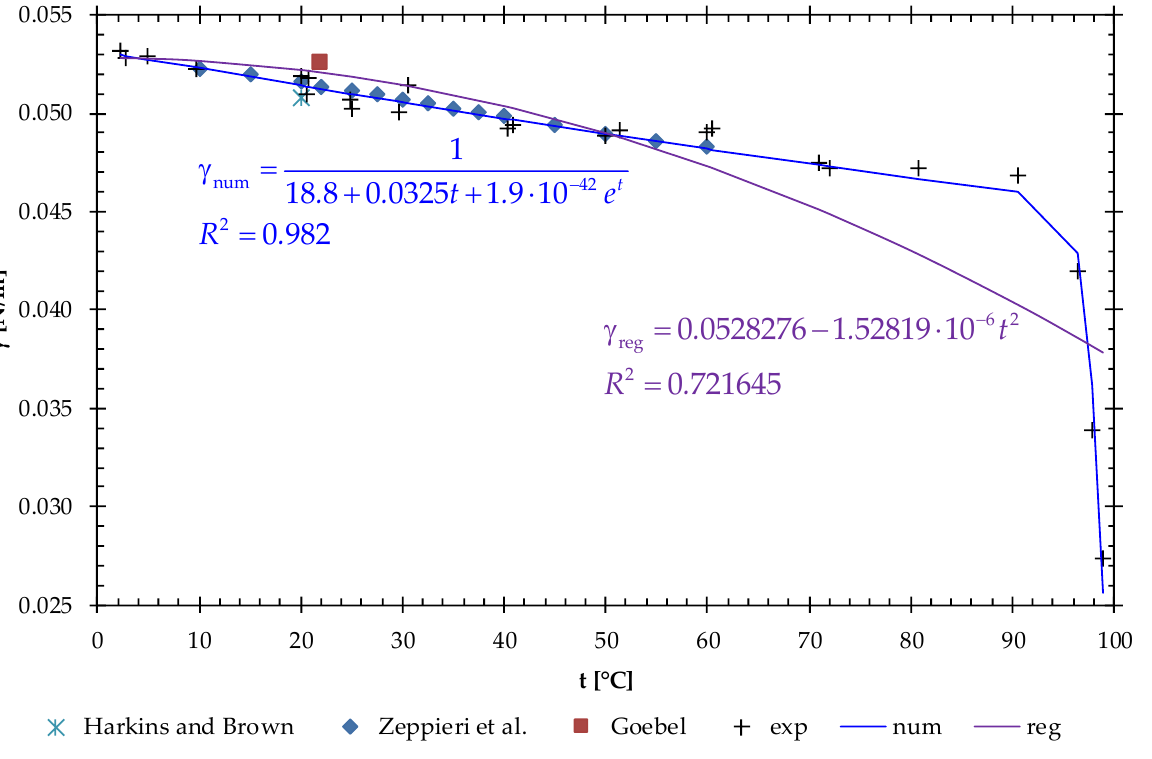
Table 1. The results of the spare equation (49) for the determined interface tensions. Lp.